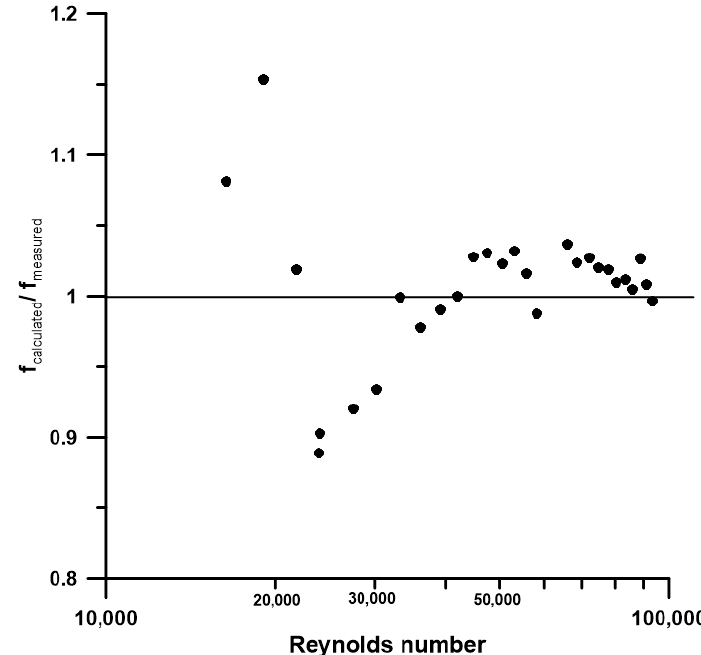
Figure 8. Comparison of calculated and measured values of the friction factor.